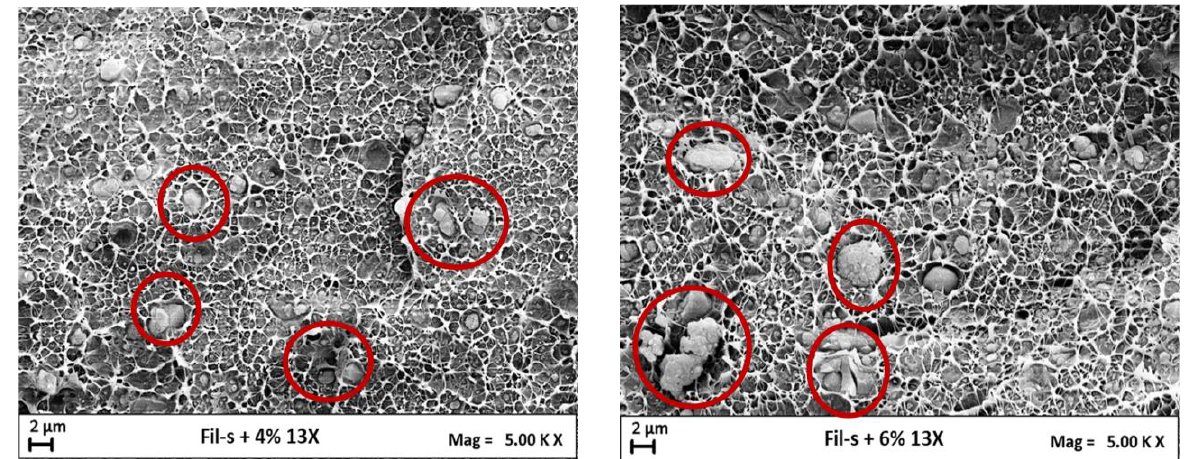
Figure 11. SEM images of Fil-S+4% 13X and Fil-S+6% 13X. Red circles highlight zeolite’s particles.